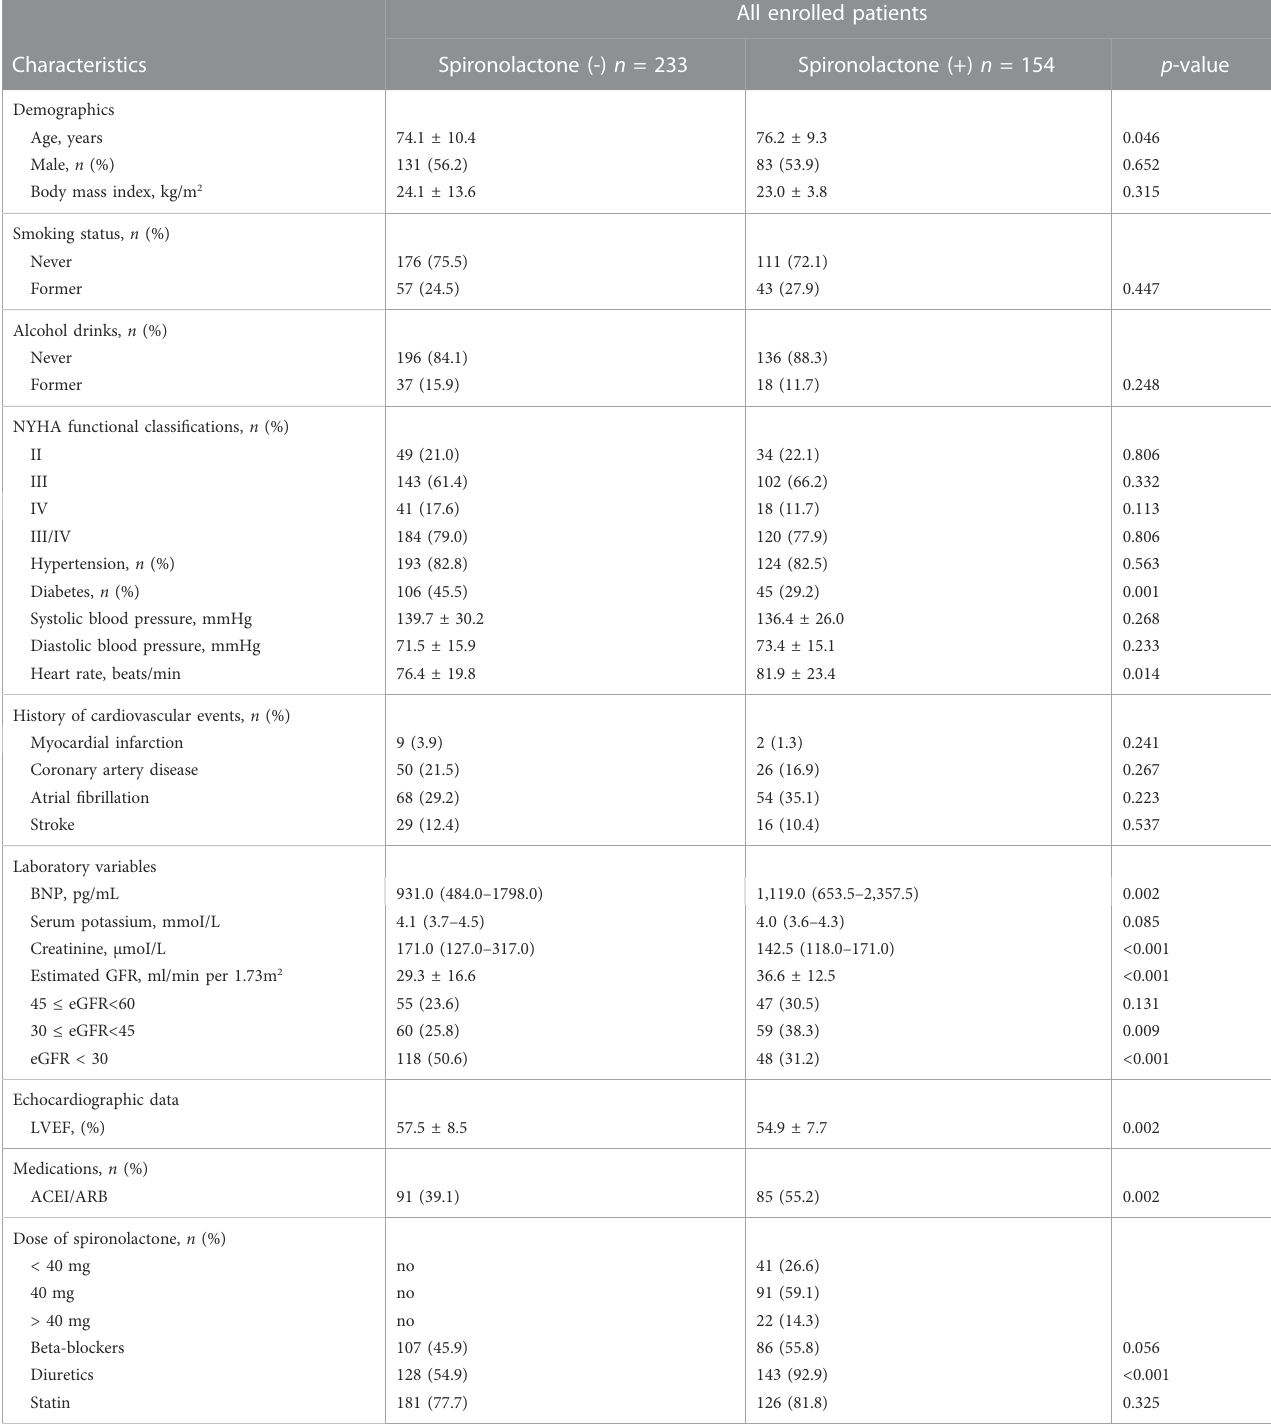
TABLE 1 Baseline characteristics of study patients with chronic kidney disease.